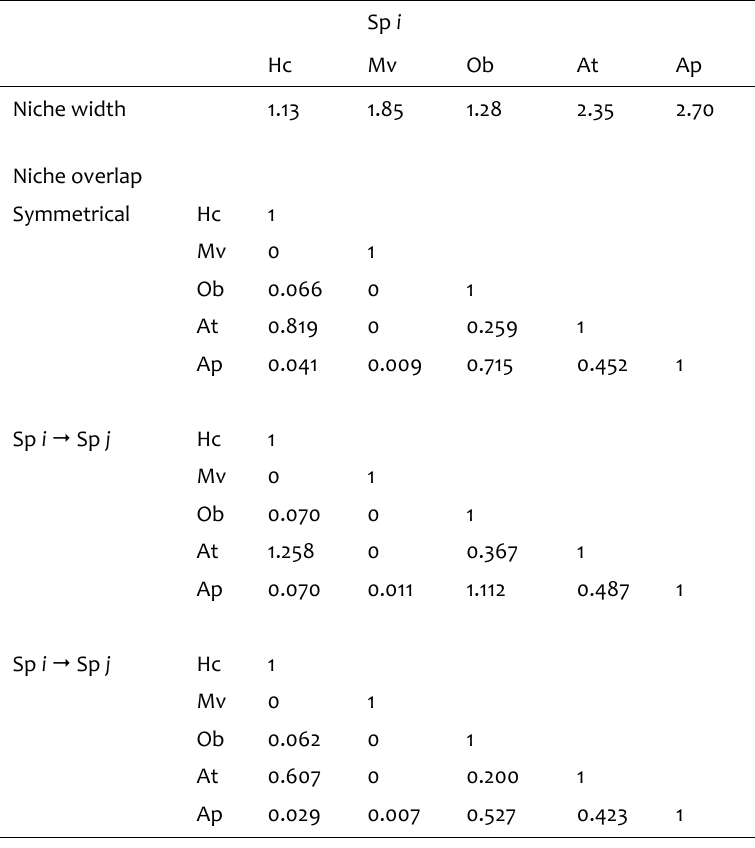
Table 3. Niche width and niche overlap among five species of stem-nesting Hymenoptera based on nest tube diameter. See Methods for details of calculations. Sp – species; Hc - Hylaeus communis ; Mv - Megachile versicolor ; Ob - Osmia bicornis ; At - Ancistrocerus trifasciatus ; Ap - Ancistrocerus parietinus